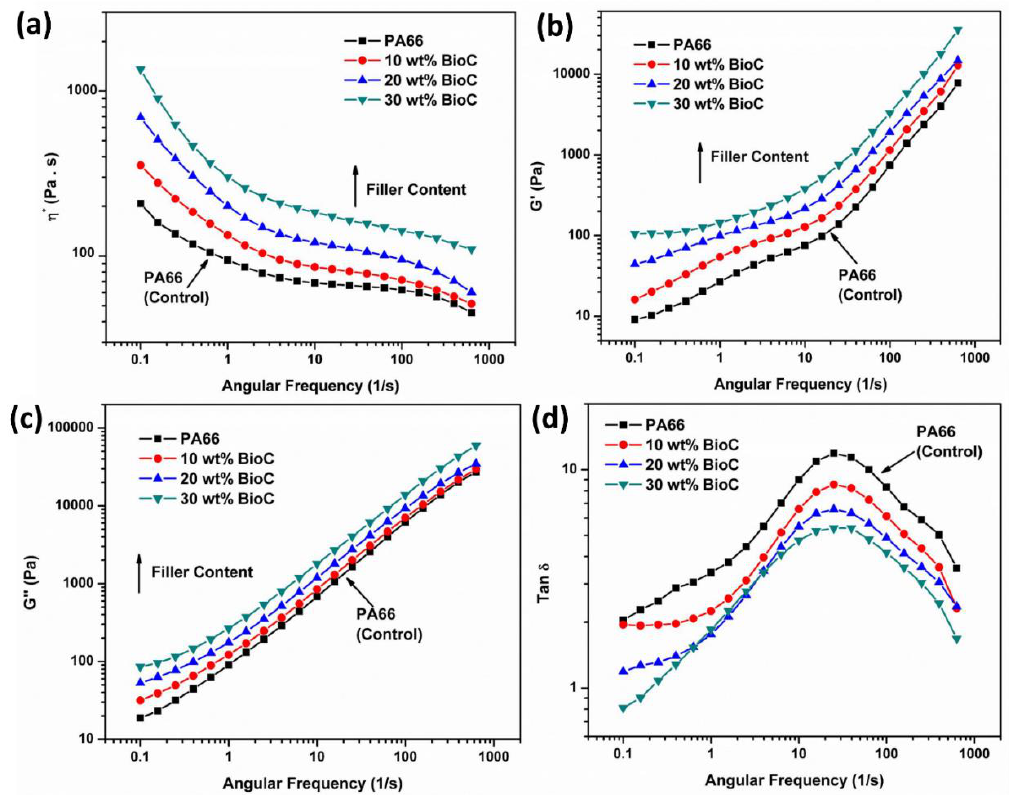
Figure 9. Rheological behavior of PA66 with different contents of 500 °C pyrolytic temperature of BioC. ( a ) complex viscosity; η *, ( b ) storage modulus; G’, ( c ) loss modulus; G’’ , and ( d ) Tan delta.